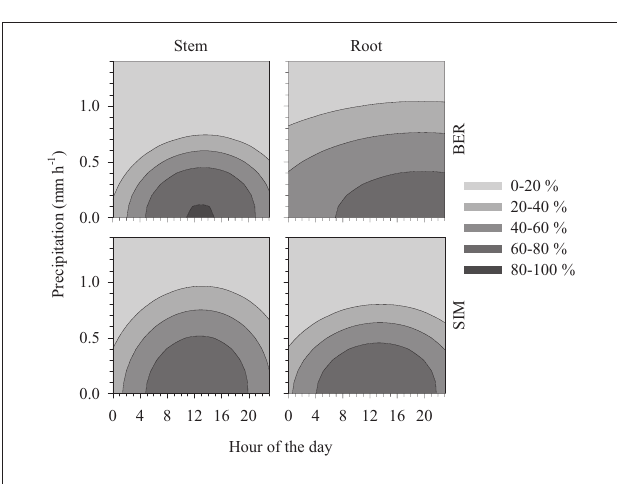
Figure 5 | Circular frequency distribution of onset of the contraction and expansion phases in stem and roots of black spruce in two stands of the boreal forest of Quebec, Canada. Hours are reported as legal time.